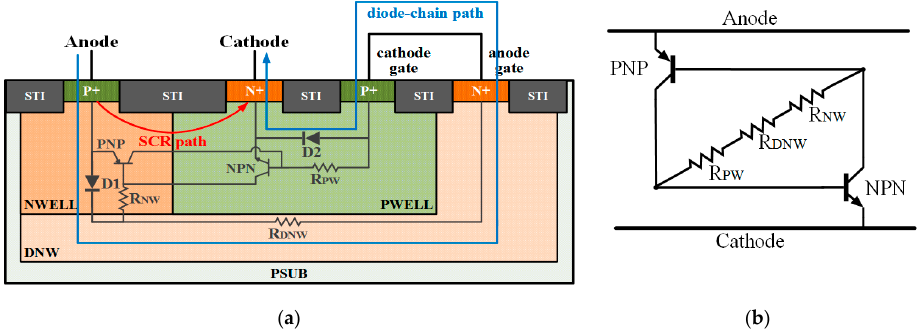
Figure 2. ( a ) Cross-sectional view of proposed ERTSCR. The DNW acts as an embedded well resistor R DNW in the trigger path; ( b ) Equivalent circuit diagram of proposed ERTSCR.